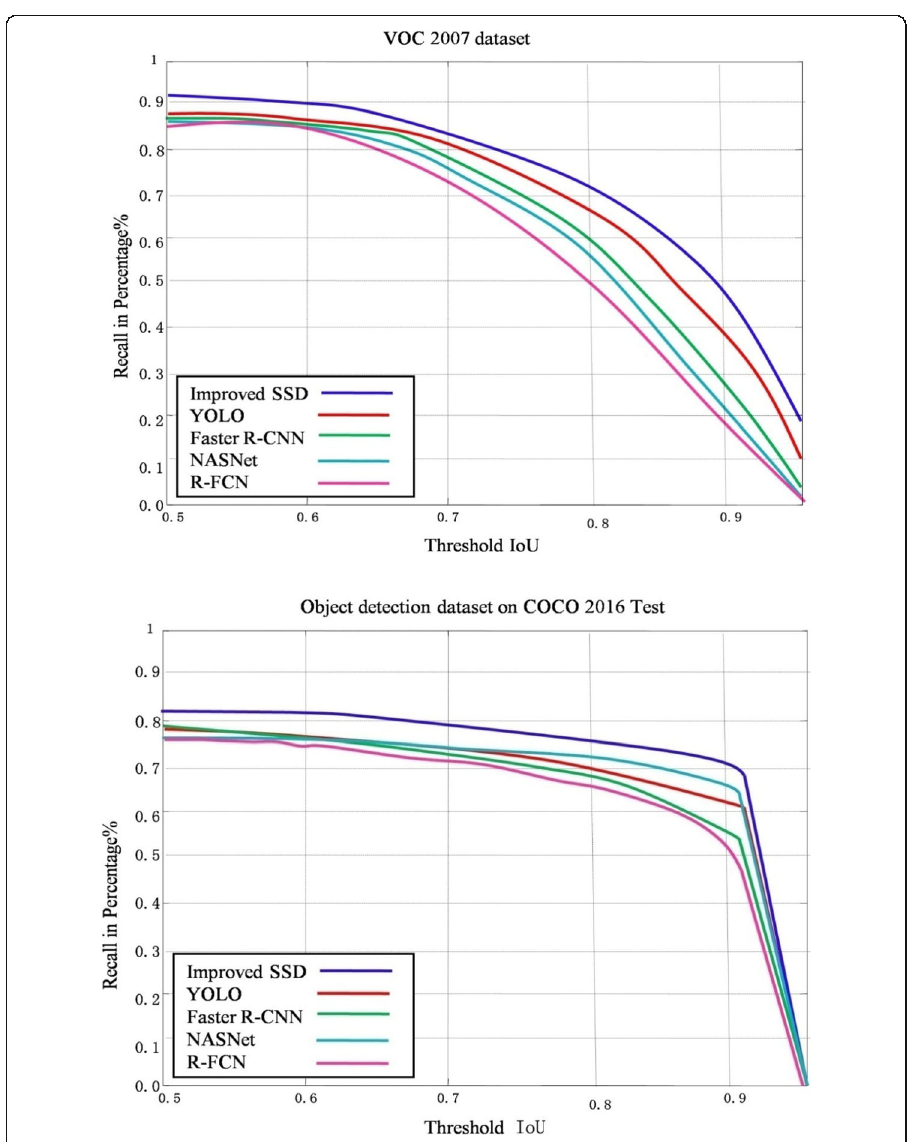
Fig. 9 Represent the different recall curves by using object detection algorithm on a particular threshold value of IoU. The proposed improved SSD approach has higher recall value, i.e., 0.9 compare with YOLO, faster R-CNN, NASNet, R-FCN as shown in a . b Demonstrates the graph of recall % vs threshold IoU compared with other object detection technique such YOLO, faster R-CNN, NASNet, and R-FCN on object detection (OD) dataset from our Centre for Image processing Lab. The recall value of improved SSD algorithm is 79.8% when the different value of IoU is